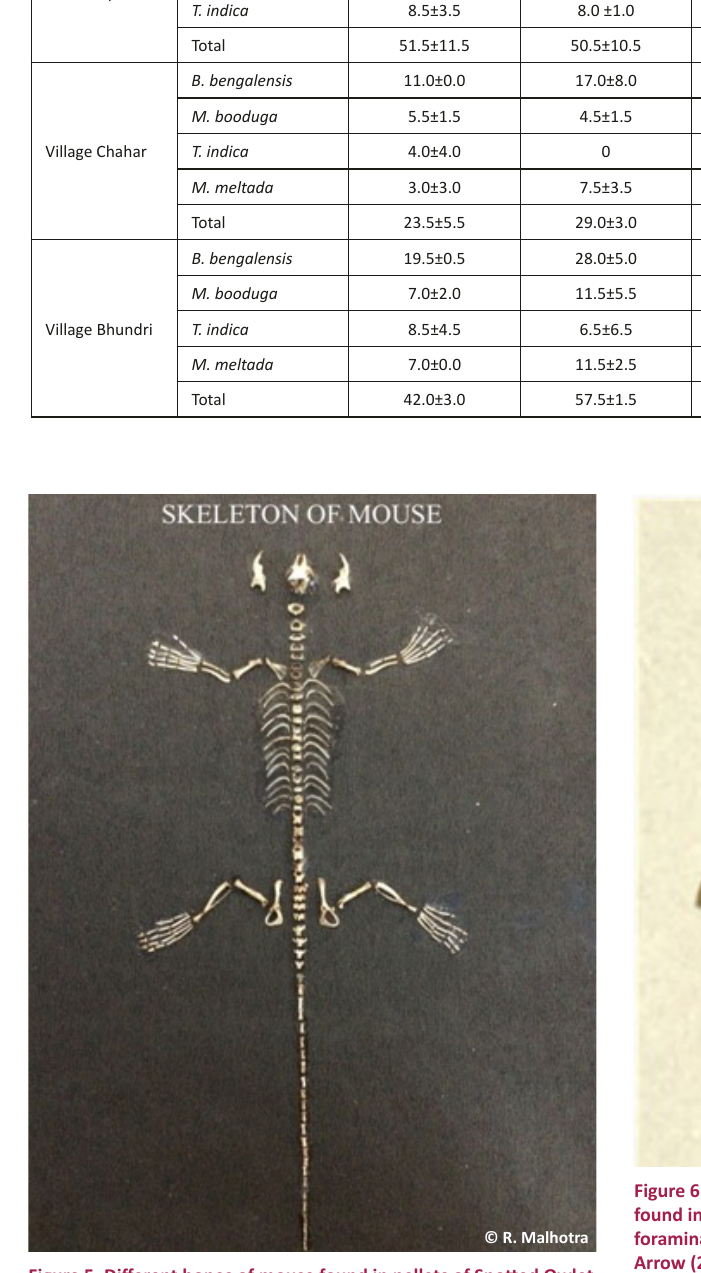
Figure 5. Different bones of mouse found in pellets of Spotted Owlet and arranged to show the complete skeleton.